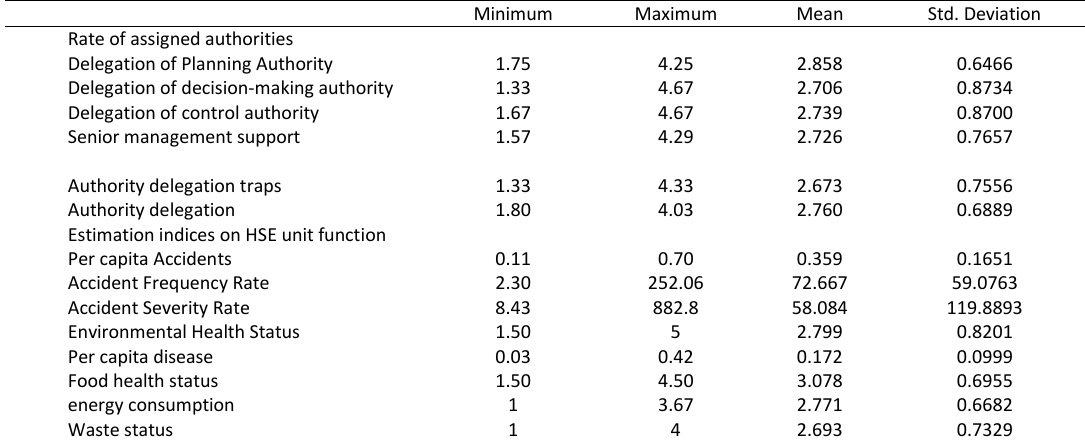
Table 1 . The status of the research variables